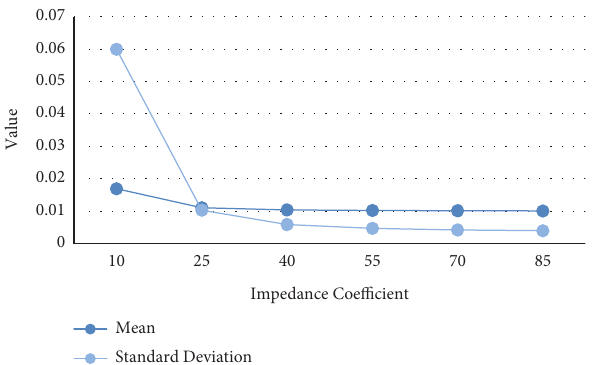
Figure 5: The standard deviations and means of SPAI with different impedance